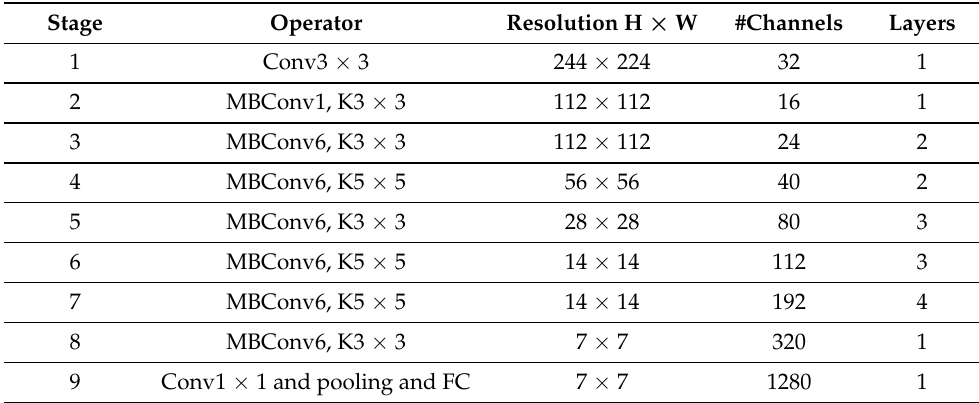
Table 1. The EffecientNet-B0 general architecture